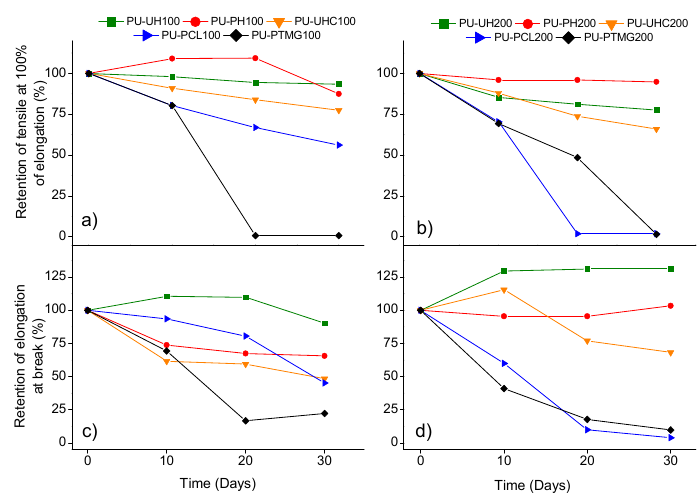
Polymers 2019 , 11 , 1910 Figure 7. Durability test under oil resistance: ( a ) and ( b ), retention of tensile strength at 100% of elongation; ( c ) and ( d ), retention of elongation at break.